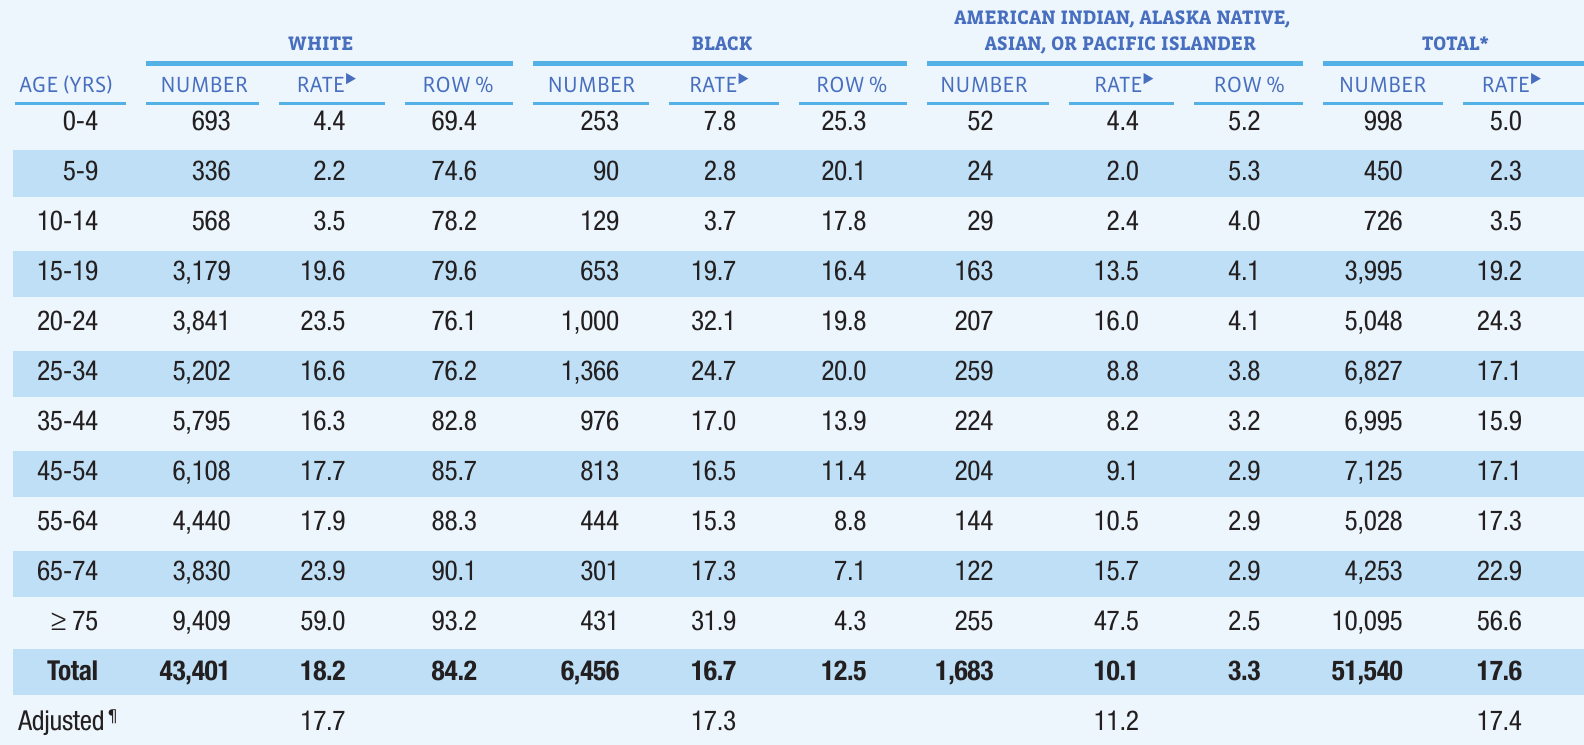
TABLE 15: Average Annual Numbers, Rates, and Percentages of Traumatic Brain Injury-Related Deaths, by Age Group and Race, United States,